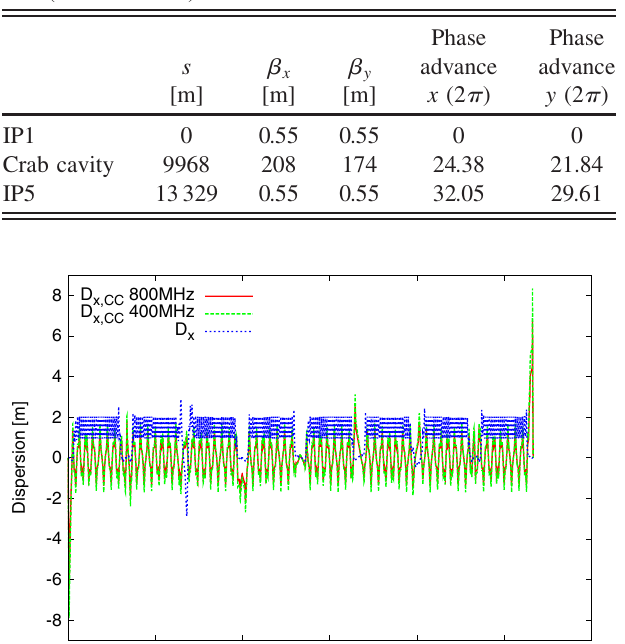
TABLE I. Parameters at IP1&IP5 and at the crab-cavity loca- tion (nominal